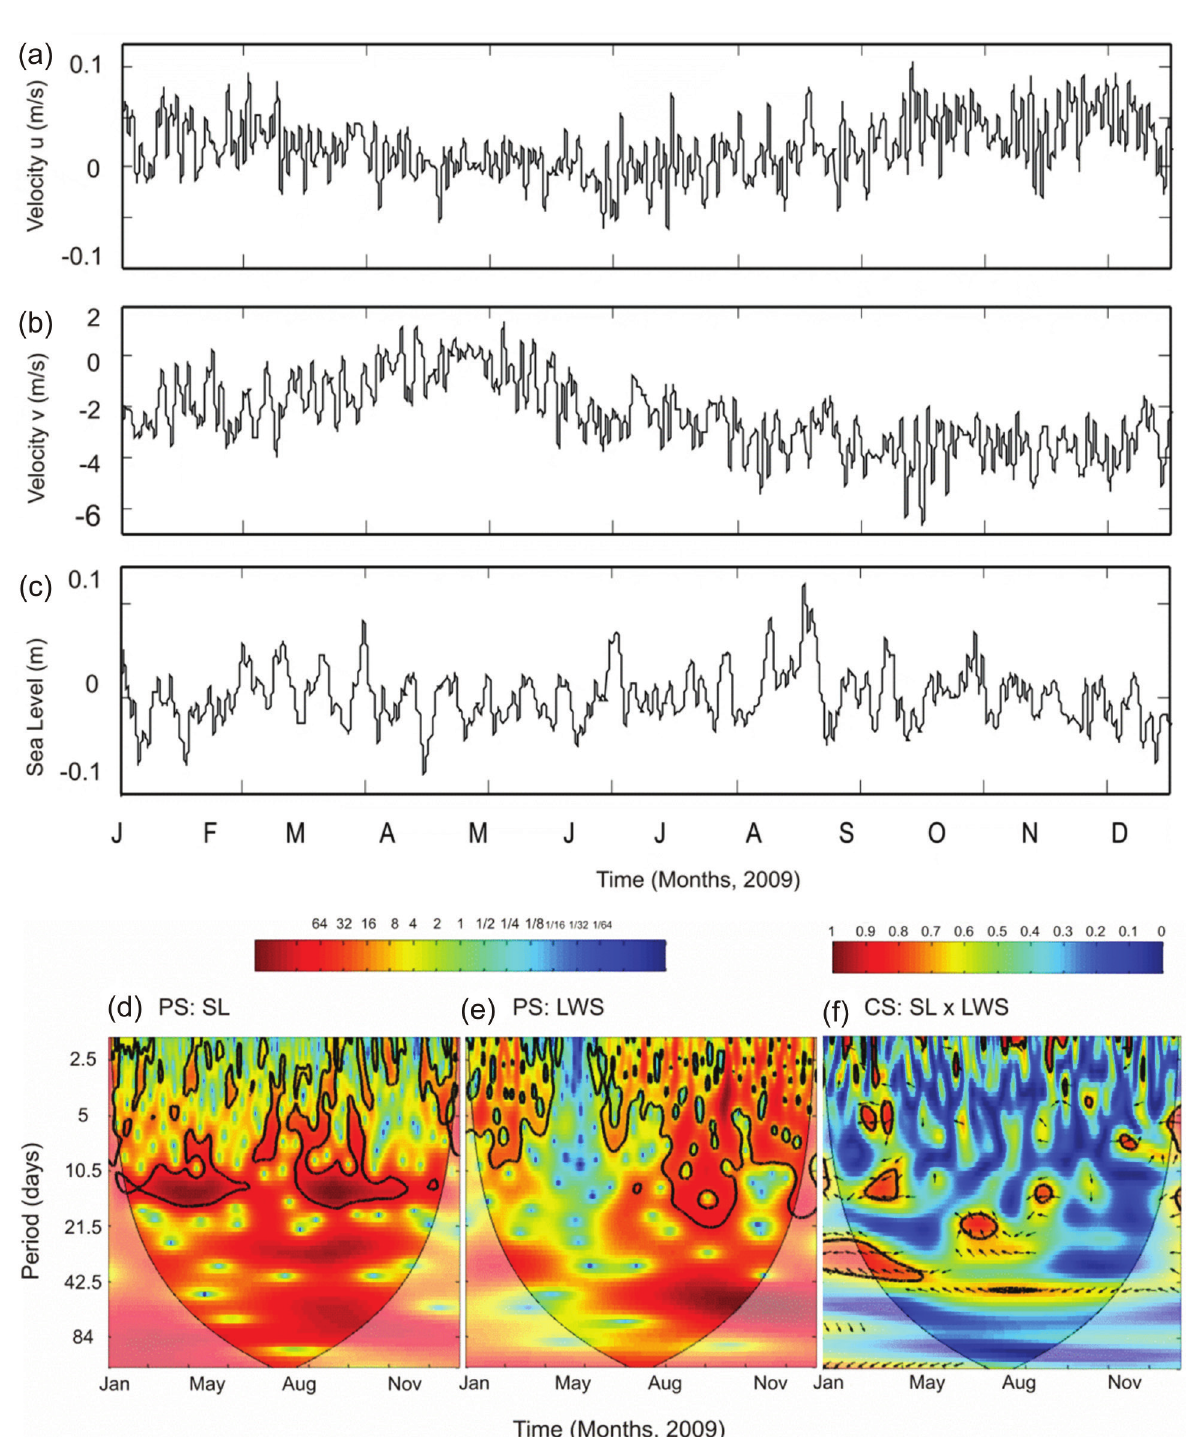
Figure 6 - Time series of sub-tidal signals of (a) alongshore and (b) cross-shore wind velocity components and (c) sea level. Wavelet power spectra (PS) of (d) sea level (SL) and (e) alongshore wind stress (LWS), and (f) wavelet coherence and phase spectrum (CS) between wind stress and sea